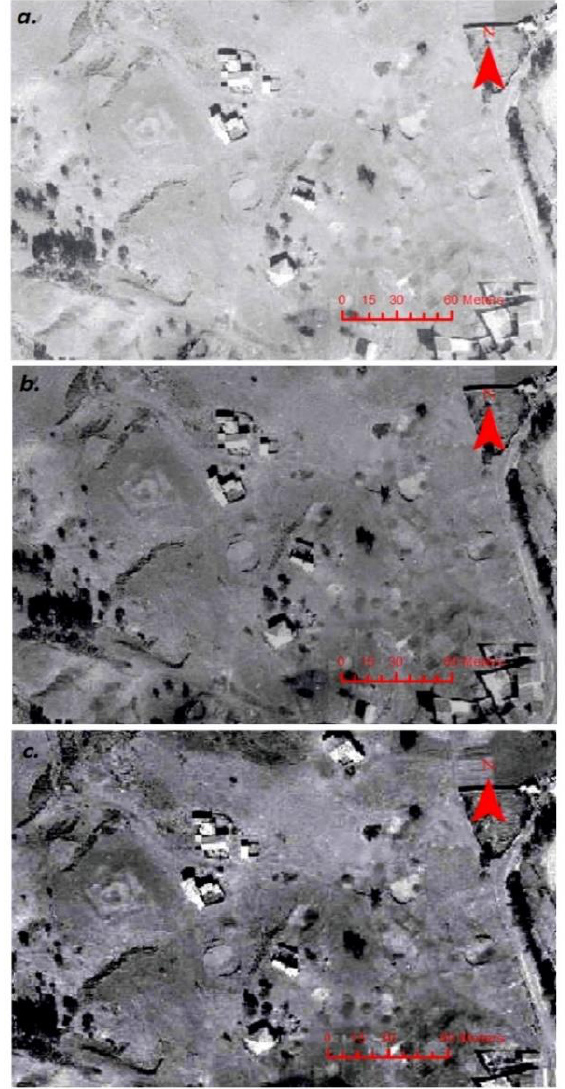
Figure 3 . Part from an aerial photograph of 1963 used in this study; a. original photograph - no enhancement applied, b. contrast adjustments applied, c. histogram equalization